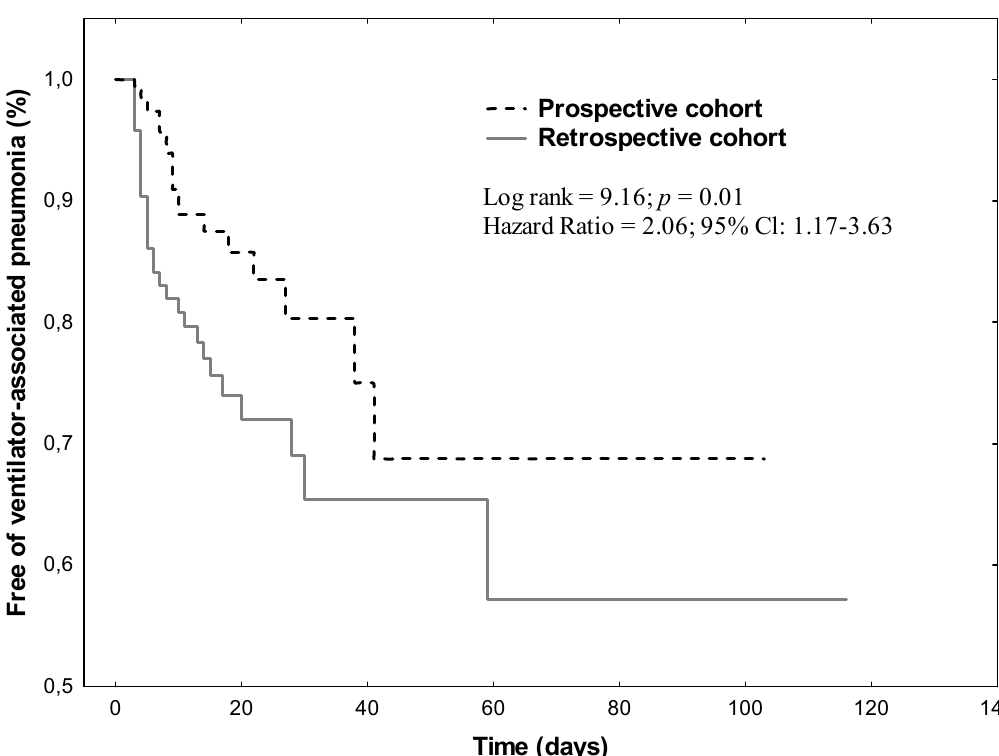
Figure 2. Kaplan–Meier curves of cumulative rates of patients remaining free of ventilator-associated pneumonia in two cohorts (the risk of ventilator-associated pneumonia is 2.06 times higher in the retrospective cohort than in the prospective